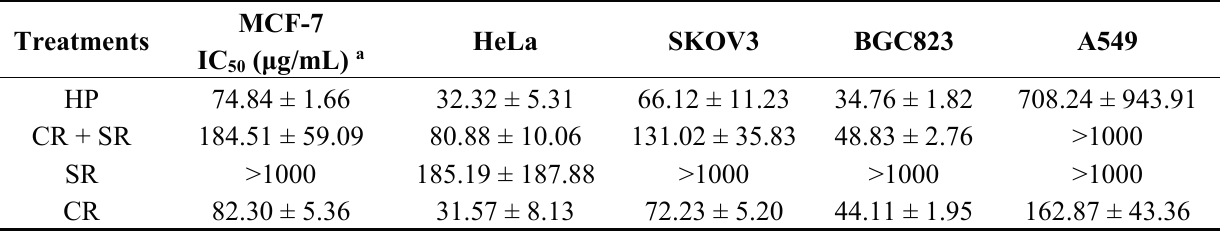
Table 2. In vitro cytotoxic activities of the essential